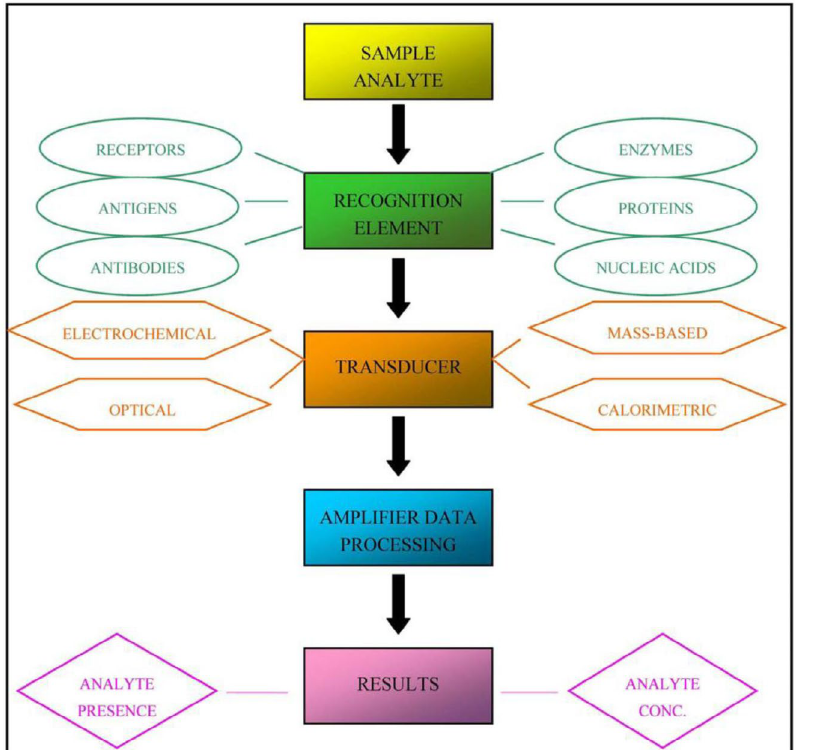
Fig. 2. Different types of bioreceptors and transducers used in biosensor fabrication. Reprinted with the permission from ref.